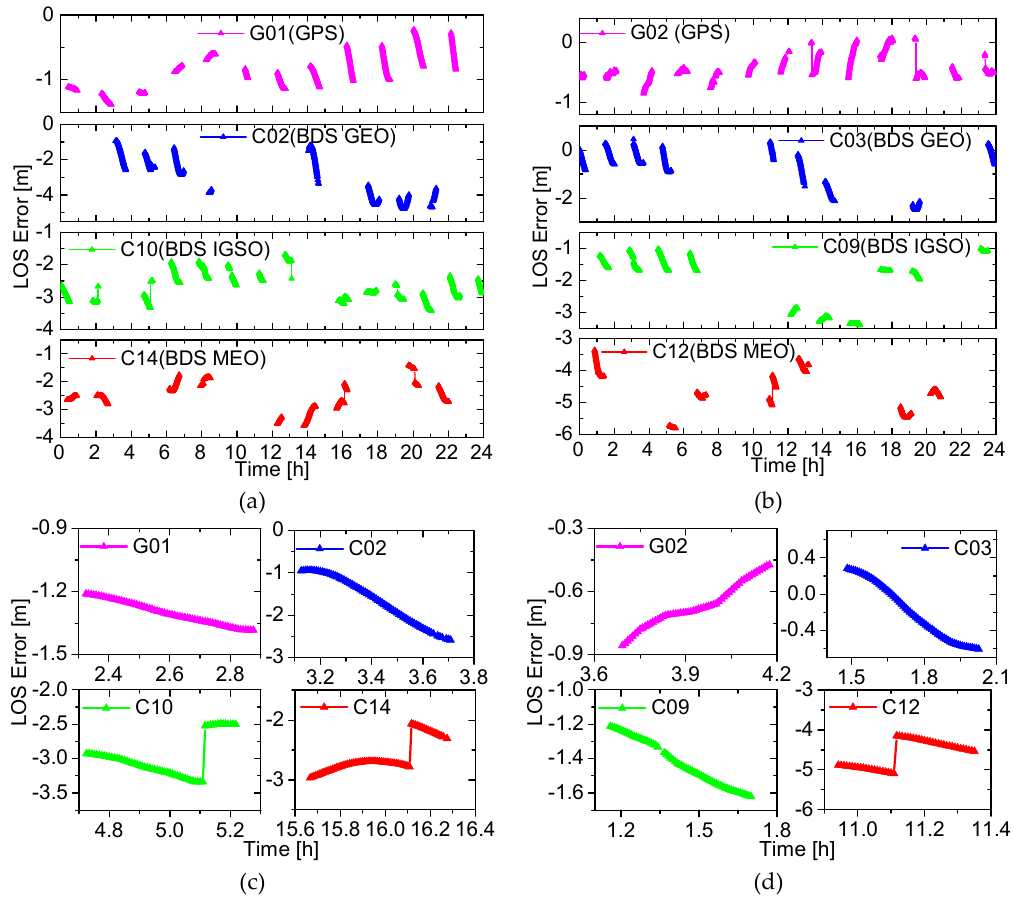
Figure 1. Line-of-sight (LOS) errors of the Global Positioning System (GPS)/BeiDou Navigation Satellite System (BDS) satellites: ( a ) the LOS error curves of GPS (G01), geosynchronous Earth orbit (GEO) (C02), inclined geosynchronous Earth orbit (IGSO) (C10) and medium Earth orbit (MEO) (C14) satellites of BDS on DOY 71, 2015; ( b ) the LOS error curves of GPS (G02), GEO (C03), IGSO (C09) and MEO (C12) satellites of BDS on DOY 71, 2015; ( c ) the LOS error curves of the 2nd tracking arc of G01, the 1st one of C02, the 3rd one of C10 and the 7th of C14; ( d ) the LOS error curves of the 3rd tracking arc of G02, the 2nd one of C03, the 2nd one of C09 and the 4th of C12.